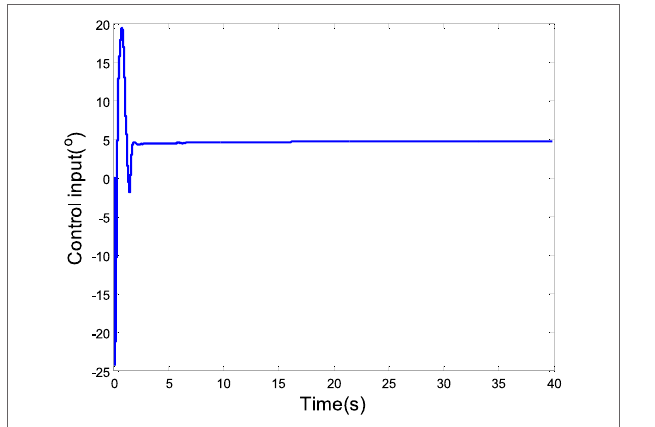
FIGURE 3 | Control input.